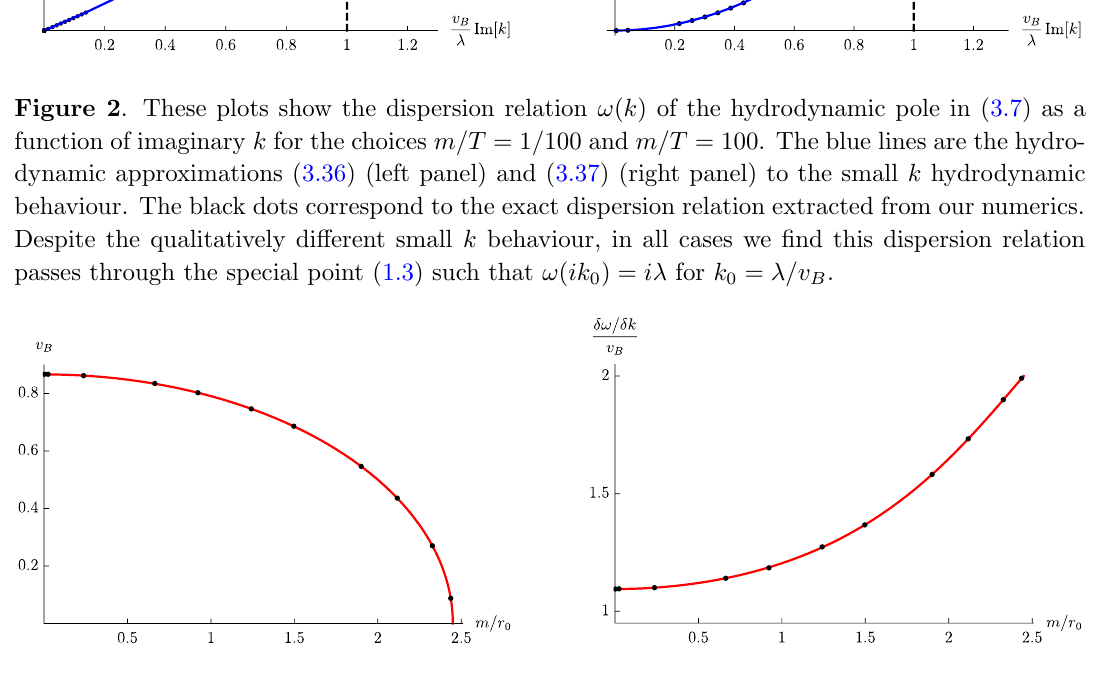
Figure 3 . (a) The red line plots the butter(cid:13)y velocity v B = (cid:21)=k 0 as determined from the analytic formula (3.3). The black dots correspond to (cid:21)=k 1 where k 1 is extracted as the wavevector for which the numerical dispersion relation for the hydrodynamic pole satis(cid:12)es ! ( ik 1 ) = i(cid:21) . If the pole passes through (1.3) then we should have (cid:21)=k 1 = v B which indeed holds for all m=T . (b) The red line plots the analytic formula (3.28) for the slope of the line of poles in the energy density correlator as it passes through the point (1.3). The dots correspond to the values of the slope extracted from the numerical calculations of the dispersion relation. Note that m=T corresponds to m = p 6 r 0 , ! 1 which is the upper limit shown on each